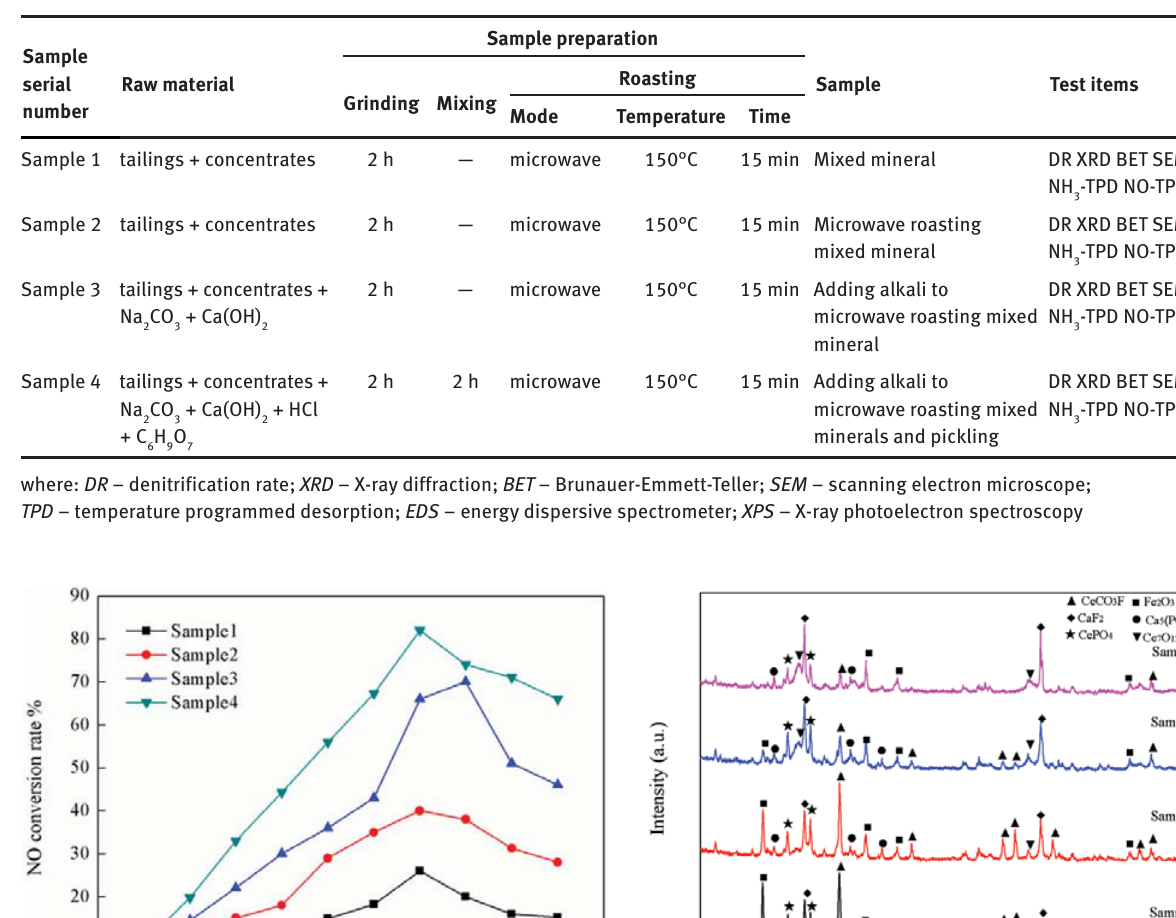
Table 2: Preparation procedure and test plan of mineral denitrification catalyst.